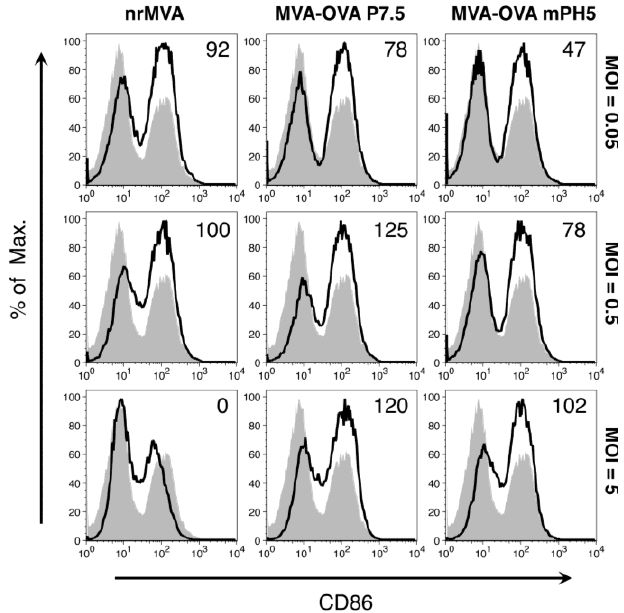
Figure 2. DC CD86 expression depends on the MOI of MVA. DCs were infected with nrMVA, MVA-OVA P7.5, and MVA-OVA mPH5 at different MOIs for 6 h. After washing and further incubation for 16 h, changes in the expression of CD86 were measured by flow cytometry. The MOIs of 0.05, 0.5, and 5 were arbitrarily considered as representative of low, intermediate and high MOI, respectively (open histograms). Mock infected DCs (MVA = 0, shaded histogram) was considered as a basal level of CD86 expression. Numbers in the upper right corners indicate fold-changes as